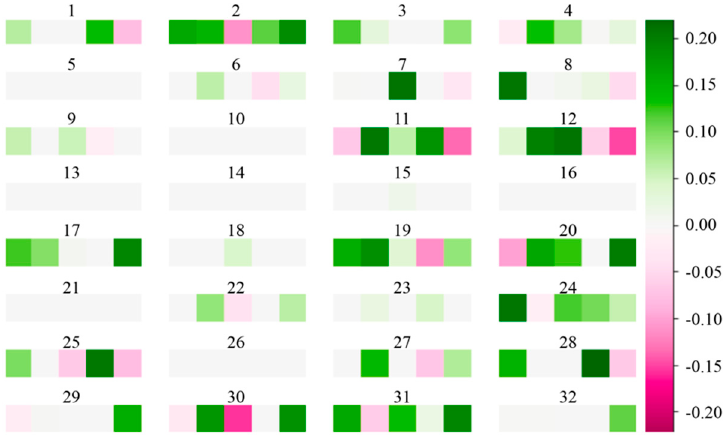
Figure 6. Kernel visualization in the first convolution layer of the SCDA model. There are 32 kernels in the first convolution layer, and each kernel has five squares. The squares in green indicate positive weights, and those in magenta represent negative weights. The deeper the color, the larger the absolute value of the weight. The grey squares represent weights with zero values.